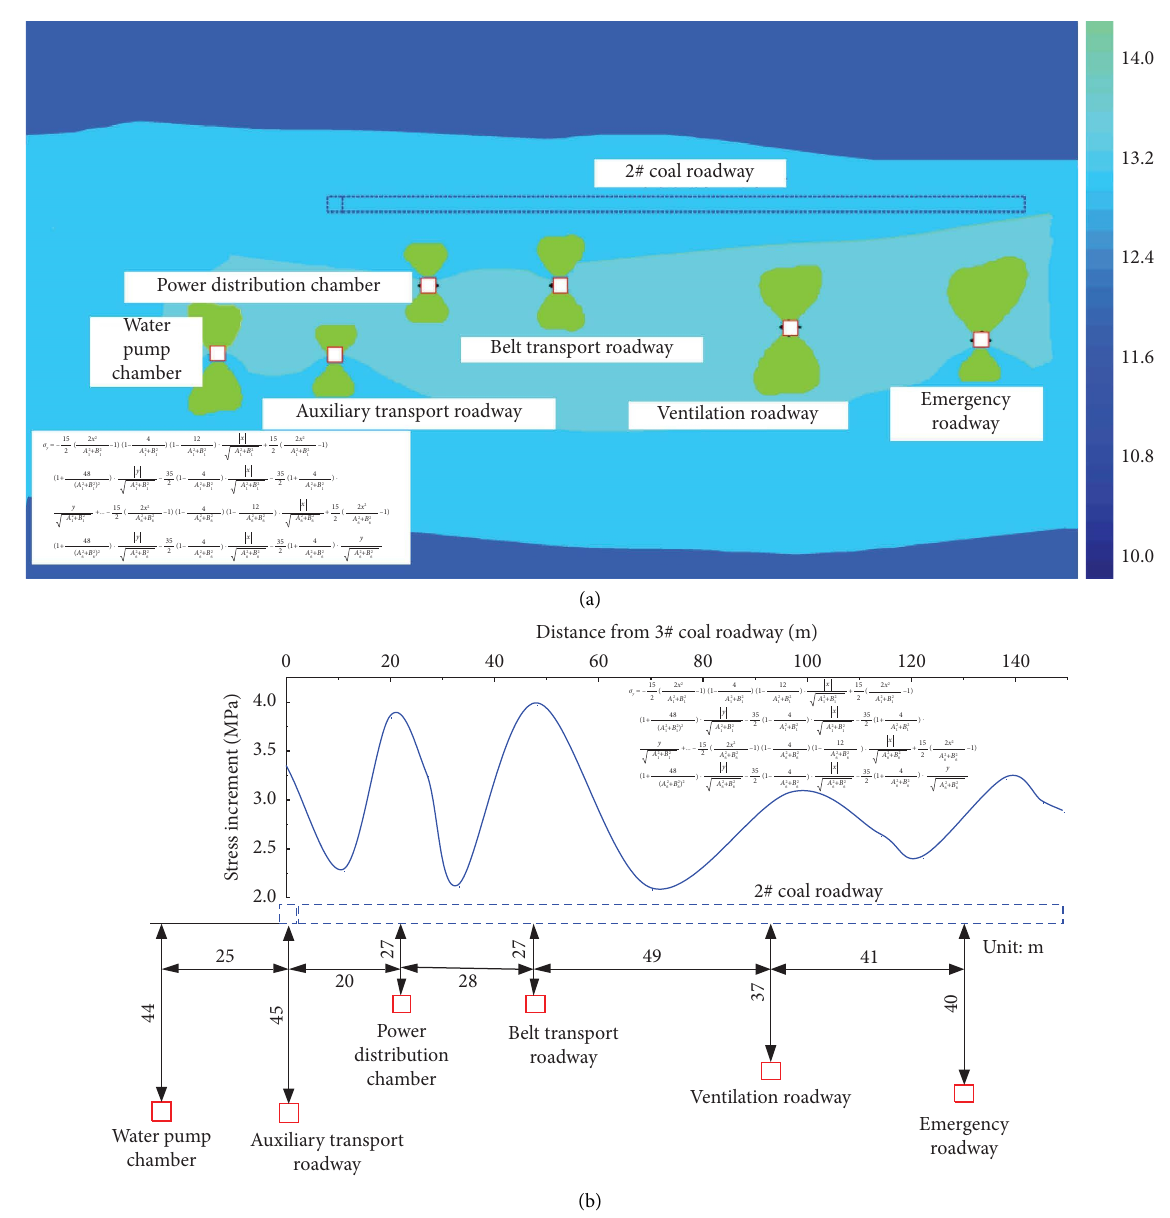
Figure 6: Calculation results of vertical stress adjustment of 2# coal roadway. (a) Vertical stress nephogram of 2# coal roadway and (b) vertical stress distribution curve of 2# coal